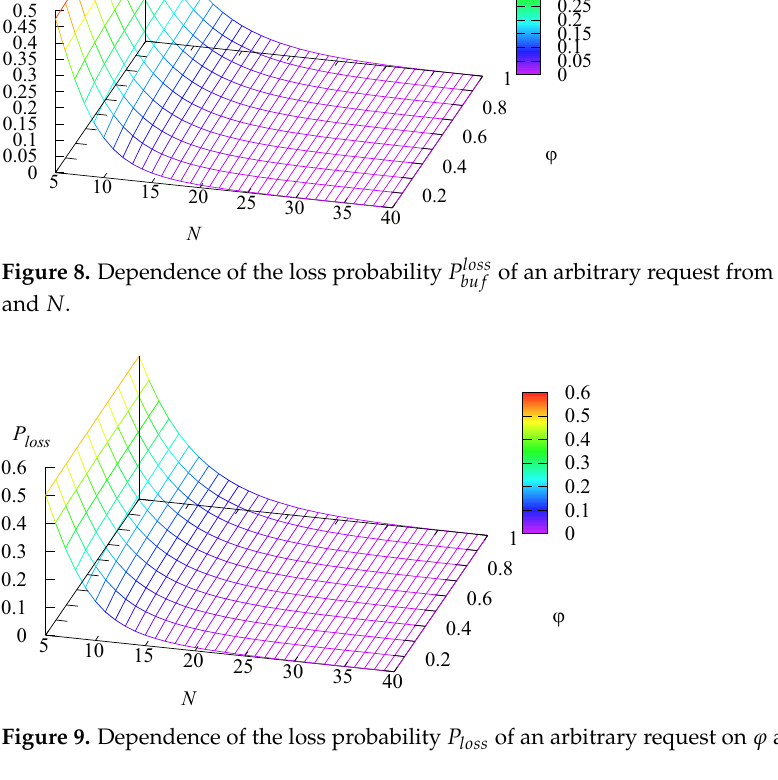
Figure 9. Dependence of the loss probability P loss of an arbitrary request on ϕ and N